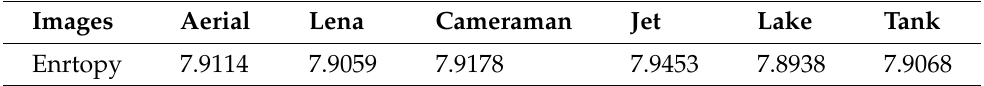
Table 5. Entropy results for encrypted